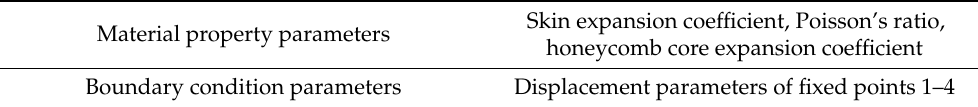
Table 6. Parameters of model